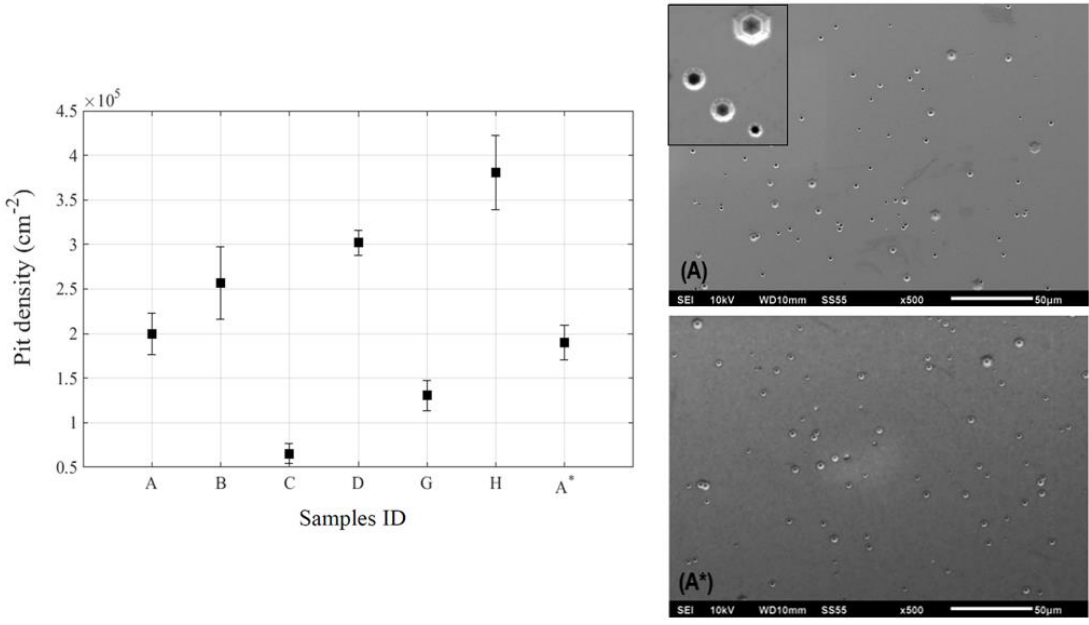
Figure 4. Pit densities measured from the SEM images of each in-situ etched GaN seed. Two exemplary SEM images are shown on the right for sample A and A*.